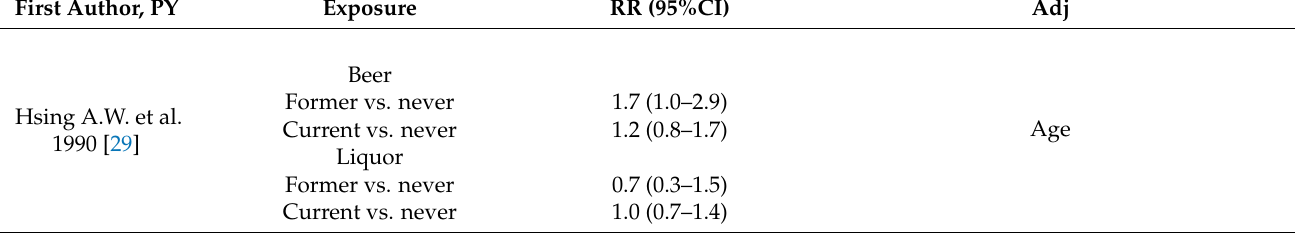
Table 1. Summary results of the studies included in the review that reported on the association between alcohol intake and the risk of fatal prostate